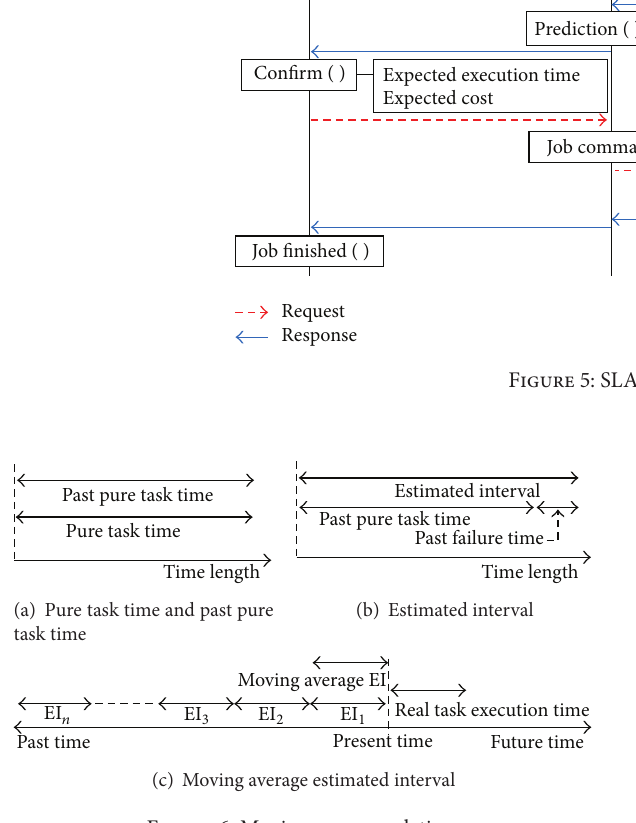
Figure 6: Moving average relation.